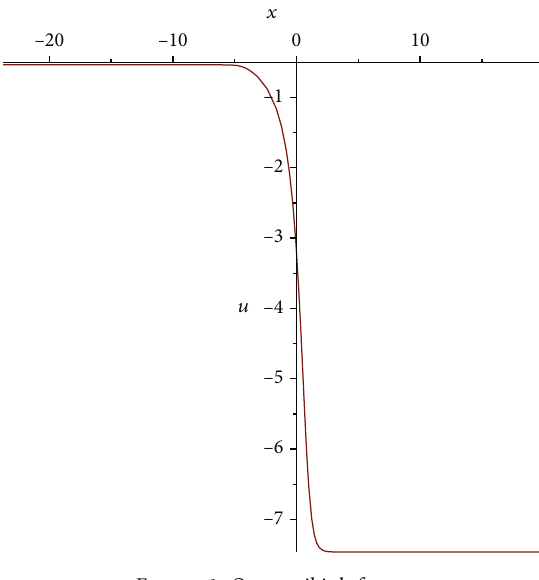
Figure 1: One antikink for u